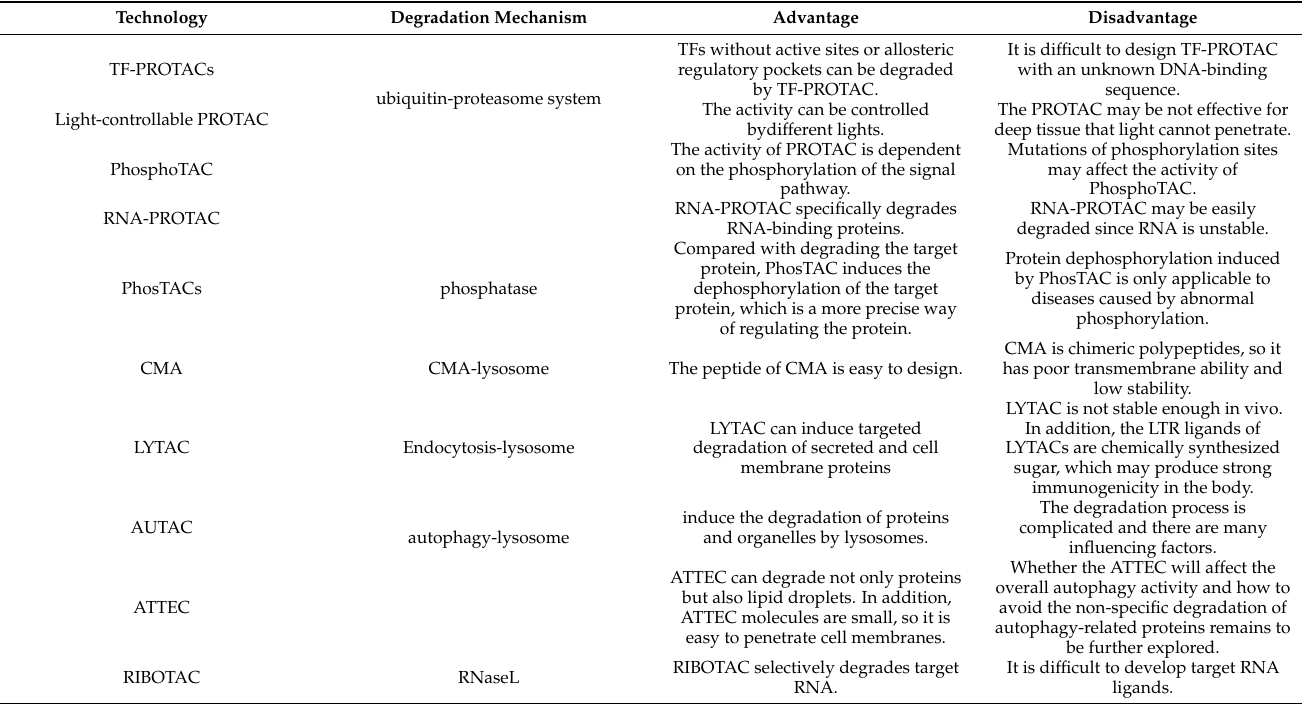
Table 1. The advantages and disadvantages of each